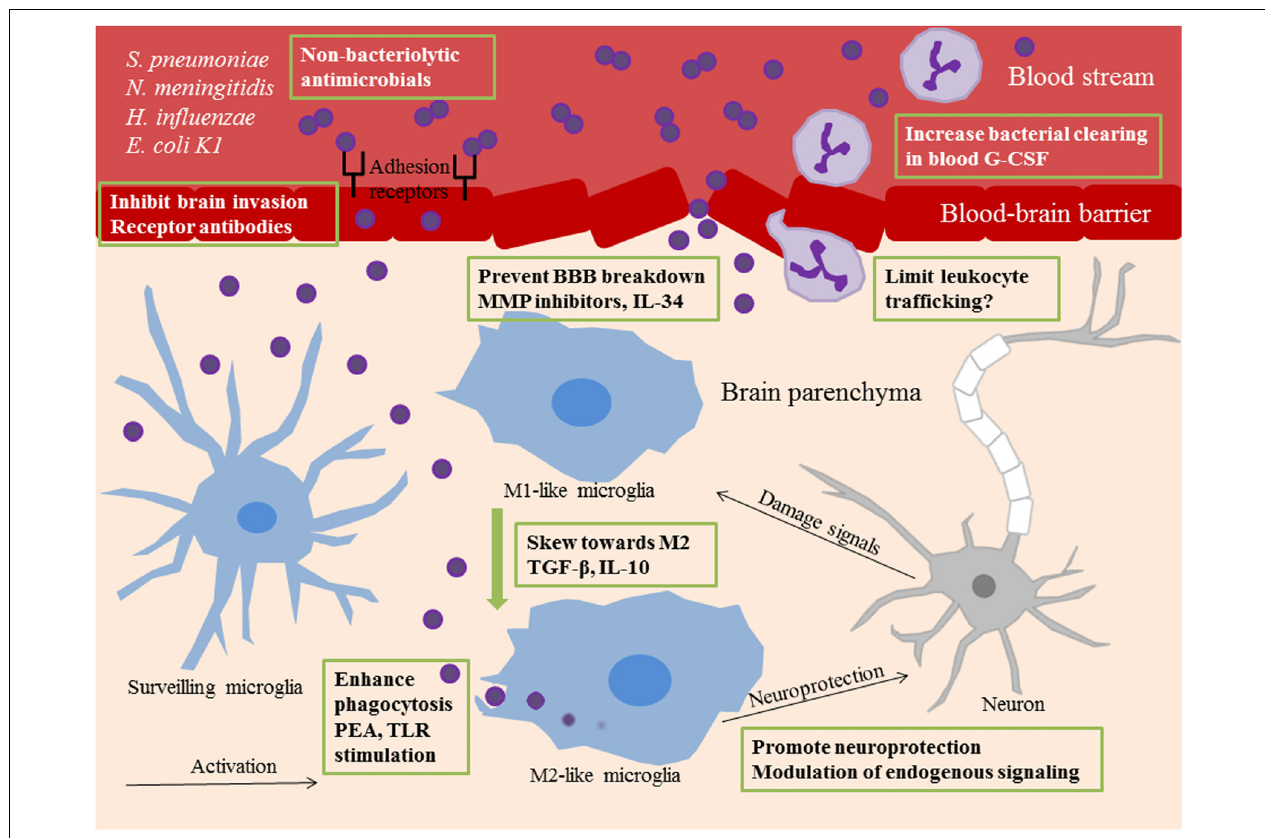
FIGURE 1 | Summary of novel therapeutic targets in bacterial meningitis. Different therapeutic strategies are shown within green frames. Surveilling microglia recognize invading bacteria or bacterial components and undergo activation. M1 polarized microglia are potent propagators of neuroinflammation. M2 polarized microglia have phagocytic and anti-inflammatory properties. In bacterial meningitis, phenotypical shift toward M2 functions can be acquired by administration of the anti-inflammatory cytokines TGF- β and IL-10. Phagocytic uptake of bacteria by microglia can be enhanced with prophylactic TLR stimulation or PEA pretreatment. The use of non-bacteriolytic antimicrobials prevents release of bacterial components into the external milieu which can feed the inflammatory response. Blockade of receptors on the blood brain endothelium prevents bacterial invasion of the brain. BBB breakdown is a consequence of neuroinflammation and can be limited with MMP inhibitors and IL-34 administration. G-CSF increases neutrophil numbers in the circulation and enhances bacterial clearing from the blood. Pharmacological blockade of leukocyte trafficking into the brain can be deleterious for disease outcome, but different approaches in limiting infiltration may be more successful. Neurogenesis and neuroprotection can be promoted via modulation of endogenous signaling pathways. TGF- β , Transforming growth factor beta; IL-10, interleukin-10; TLR, Toll-like receptor; PEA, Palmitoylethanomide; BBB, blood-brain barrier; MMP, matrix metalloproteases; IL-34, interleukin-34; G-CSF, granulocyte colony-stimulating